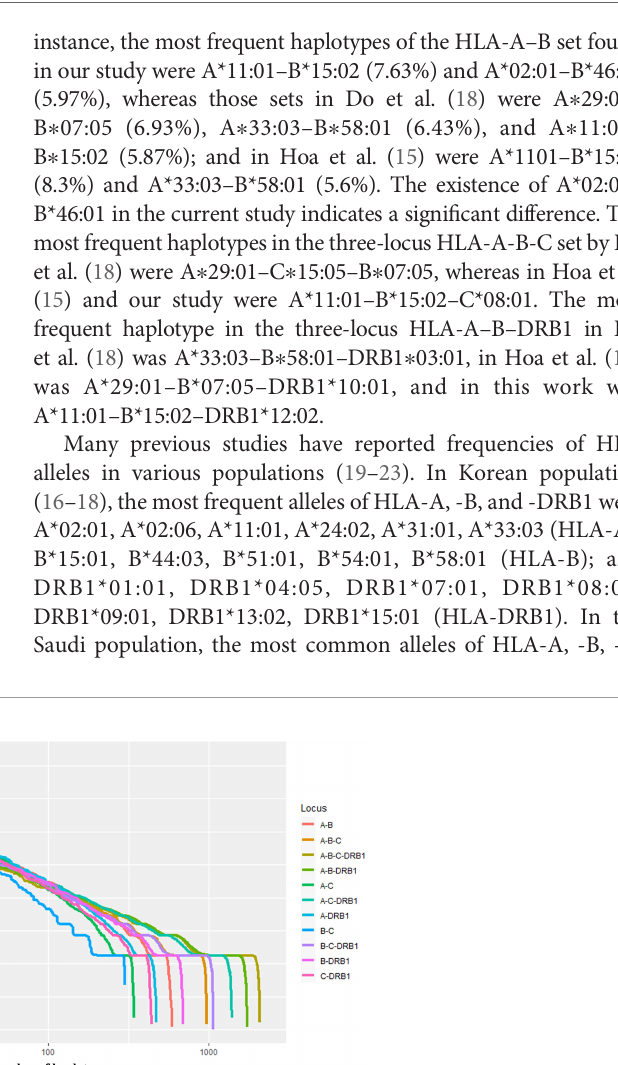
FIGURE 3 | Curves showing the cumulative haplotype frequencies of each HLA locus-combination set (A – B, A – C, A – DRB1, B – C, B – DRB1, C – DRB1, A – B – C, A – B – DRB1, A – C – DRB1, B – C – DRB1, A – B – C – DRB1). The number of haplotypes ( n ) on the x -axis is expressed on a logarithmic scale.